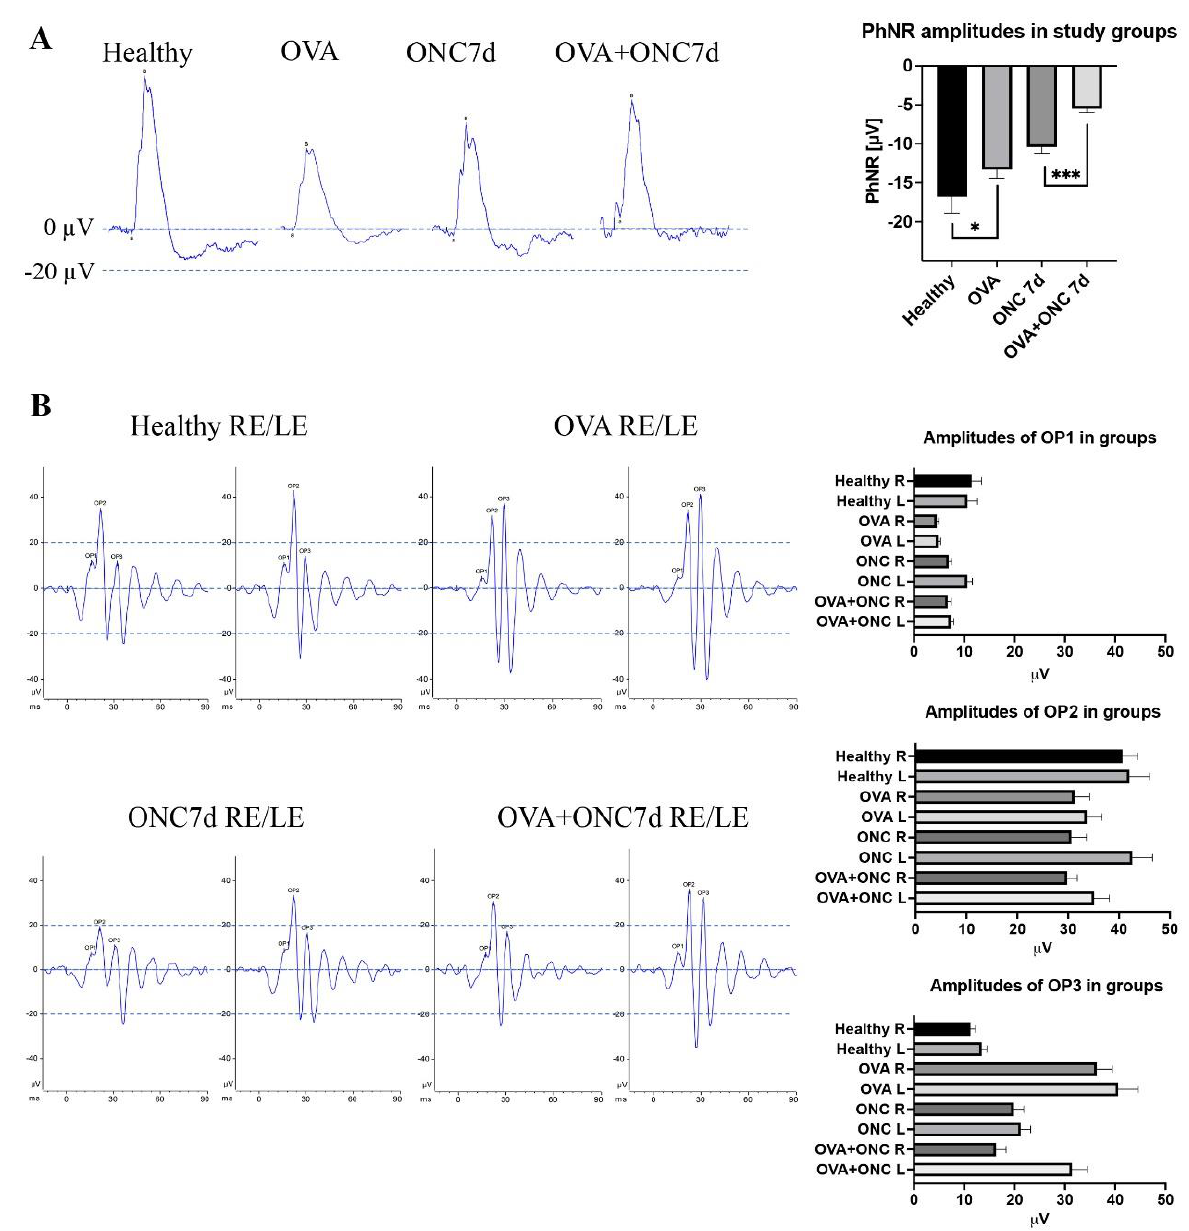
Figure 4. Functional measurements in animal groups using ERG. ( A ) Photopic negative responses (PhNR) in experimental groups, including statistical analysis of PhNR amplitudes, *: p < 0.03, ***: p < 0 .001; Welch’s t test. ( B ) Oscillatory potentials (OP) in experimental groups including descriptive statistics for OP1, OP2 and OP3. RE: right eye, LE: left eye.